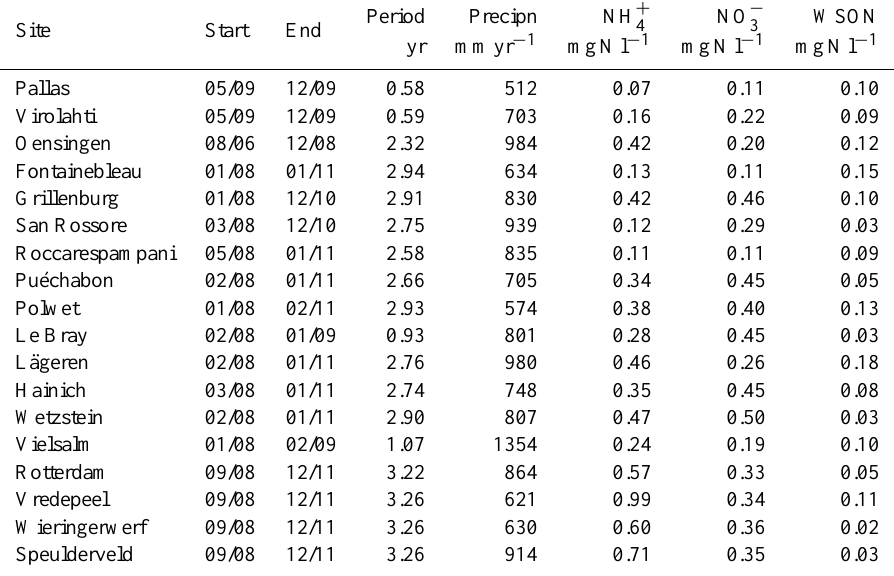
Table 2a. Average precipitation composition across all sites (precipitation weighted mean concentrations in mgNl − 1 ) .